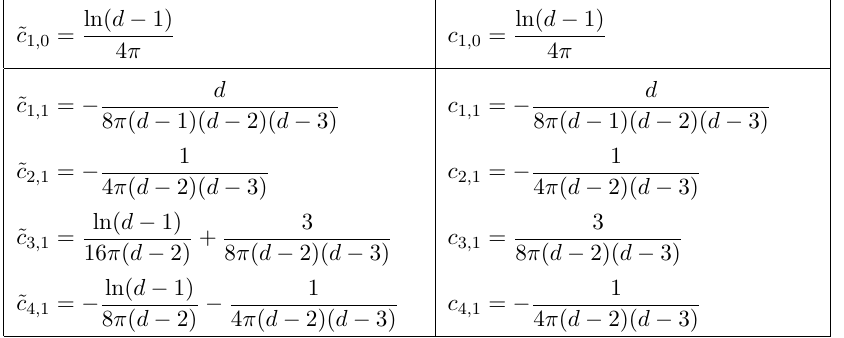
i; 1 is the coe(cid:14)cient of